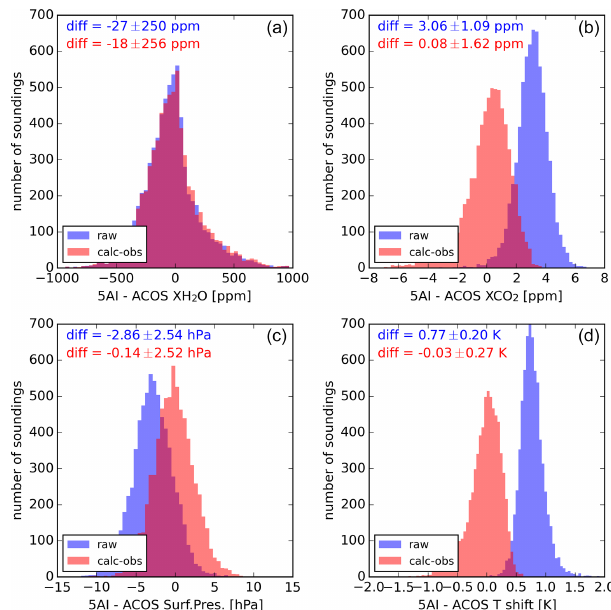
Figure 12. 5AI raw ACOS B8r difference distributions for X H (a) , X CO (b) , surface pressure (c) , and temperature profile 2 O 2 global shift (d) shown without applying the average calc–obs spec- tral residual correction (in blue) and with the correction (in